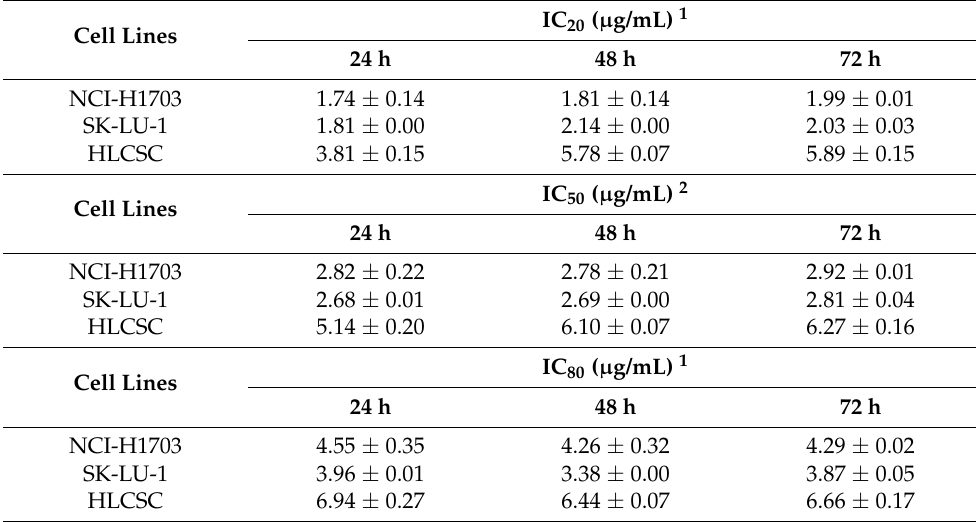
Table 4. IC 20 , IC 50 and IC 80 values of PI.